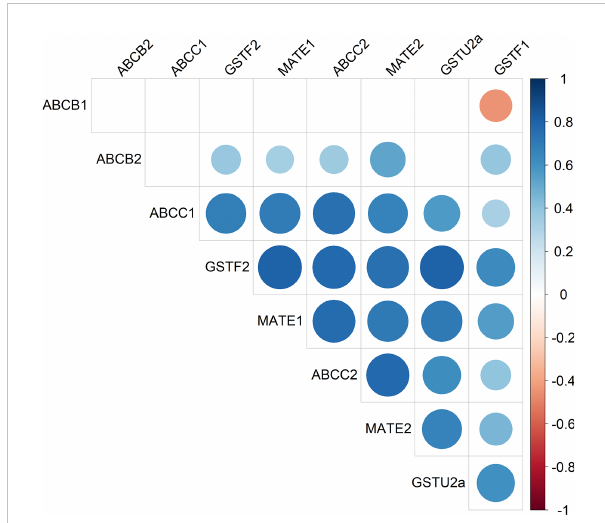
FIGURE 3 Heatmap of AmABCC1 and AmABCC2 transcripts as co-expressed with other genes encoding detoxi fi cation enzymes and transporters in blackgrass. The relative transcript expression of AmABCC1, AmACC2, AmABCB1, AmABCB2, AmMATE1, AmMATE2, AmGSTU2a, AmGSTF2 , and AmGSTF1 (n = 5) from in- fi eld derived blackgrass populations of de fi ned EMR phenotypes were compared by Spearman ’ s correlation analysis. The scale represents Spearman ’ s correlation coef fi cient, with blue circles denoting positive correlations and red circles negative